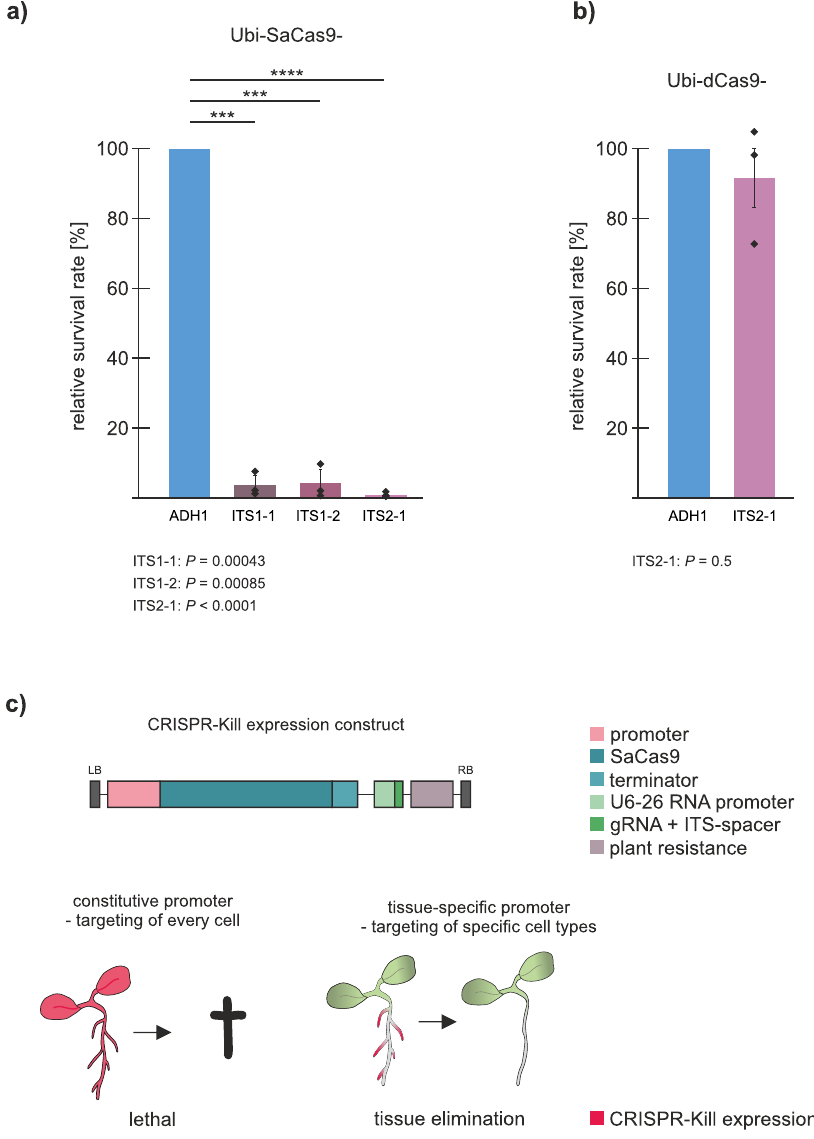
Fig. 2 Cleavage of the ITS region of the 45S rDNA repeats in Arabidopsis using SaCas9. a Cleavage of the conserved ITS region of the 45S rDNA using SaCas9 in the wild type resulted in a dramatic decrease of the number of transformants in all three ITS-targeting lines (Ubi-SaCas9-ITS1-1, Ubi-SaCas9- ITS1-2, and Ubi-SaCas9-ITS2-1) compared to the control line, Ubi-SaCas9-ADH1 ( n = 3 biologically independent experiments). Data are presented as normalized mean values ± SD. P = 0.00043 for ITS1-1; P = 0.00085 for ITS1-2; P < 0.0001 for ITS2-1. b The survival rate of lines transformed with a catalytically inactive SaCas9 (dCas9) targeting ADH1 (Ubi-dCas9-ADH1) and ITS2 (Ubi-dCas9-ITS2-1) was analyzed. No reduction in survival rate could be observed in the ITS2-1 line compared to the ADH1 line ( n = 3 biologically independent experiments). Data are presented as normalized mean values ± SD. c SaCas9 (blue) is under the expression of an exchangeable promoter (light pink). Utilization of SaCas9 under expression of a constitutive results in cleavage of the 45S rDNA in all cells (red), leading to cell death. By exchanging the constitutive promoter with a tissue-speci fi c promoter, it is possible to obtain plants devoid of individual organs. Statistical differences were calculated using the two-tailed t -test with unequal variances: * P < 0.05, ** P < 0.01, *** P < 0.001, **** P < 0.0001. Source data are provided as a Source data fi